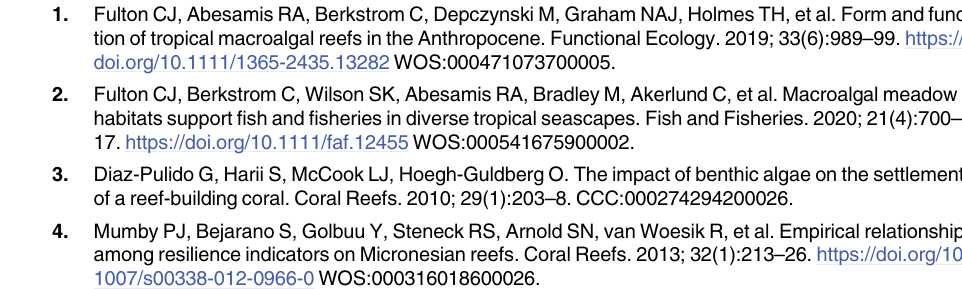
S2 Table. Hyperparameters for modelled temporal trends of macroalgae cover on individ- ual reefs are provided as separate.csv file due to the large size. Summary parameters are on the logit